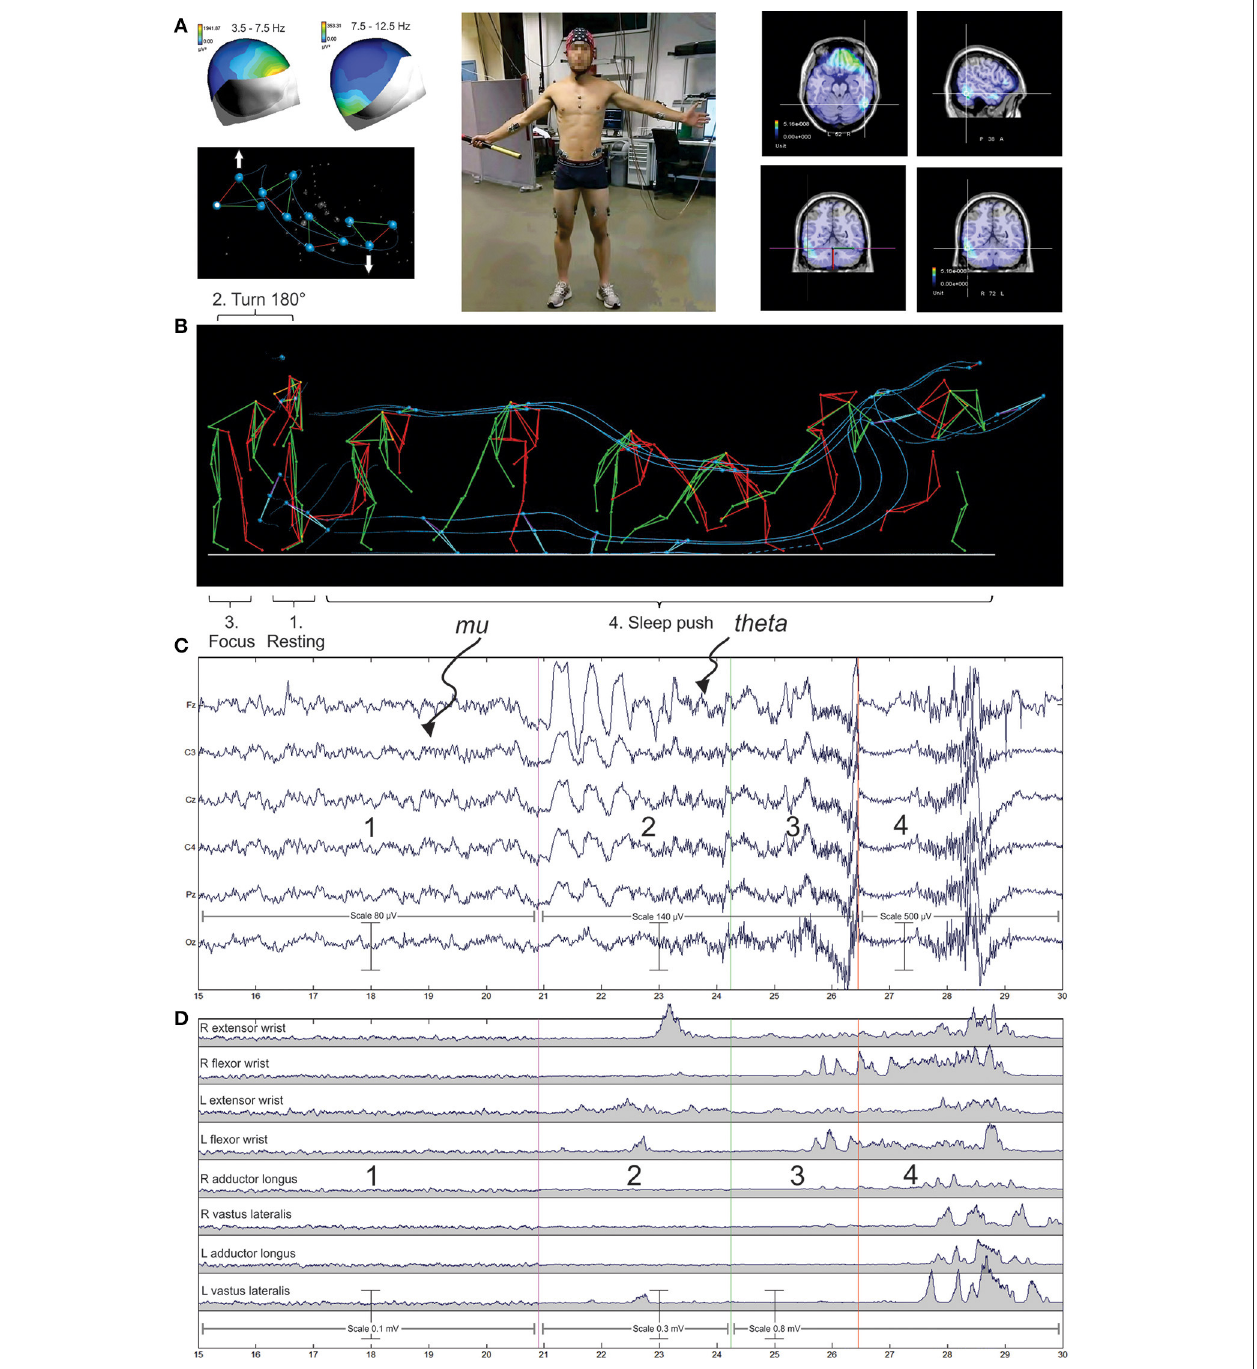
FIGURE 1 | Illustration of an integrated neurophysiological approach in sport. The sleep push or drag flicking in field hockey sport is here illustrated as an example of complex movement involving the whole body. It is an attacking movement mainly performed within the penalty corner but also realized outside the penalty corner situation. Here in our experimental setup, the player was placed in front of the laboratory wall with the field of action in its back. He was asked to relax in this position before turning in front of the action field. Then he performed the sleep push movement at its self-paced mode in order to put the ball inside of the goal. (A) The player was equipped with a 128 electrodes cap (ANT), the cables of the cap were connected to the amplifier which were placed in a traveling box piloted by the experimenter in order to assume the follow-up of the player’s running. (B) Surfaces electrodes () were placed on muscles of interest and allowed the electromyographic (EMG) recording (see, G). (C) Retro-reflective passive markers were fixed on the skin overlying the following bony landmarks on both sides of the body: LM, lateral malleolus; MT, fifth metatarsal head; LE, lateral condyle of the knee; GT, greater trochanter; and IL, tubercule of the anterosuperior iliac crest then a stick diagram of the whole body representation was constructed. (D) Kinematics of the sleep push movement, successive pictures of the main phase are presented and 3 markers placed on the head and 3 other placed on the distal part of the stick are joined by continuous lines (blue) giving a global representation of the movement signature.